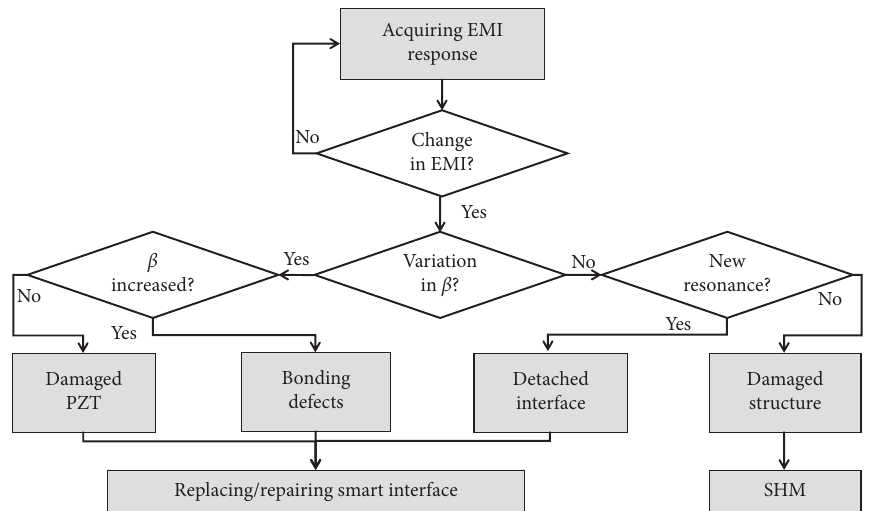
Figure 3: The diagnosis process of a damaged smart interface for SHM.